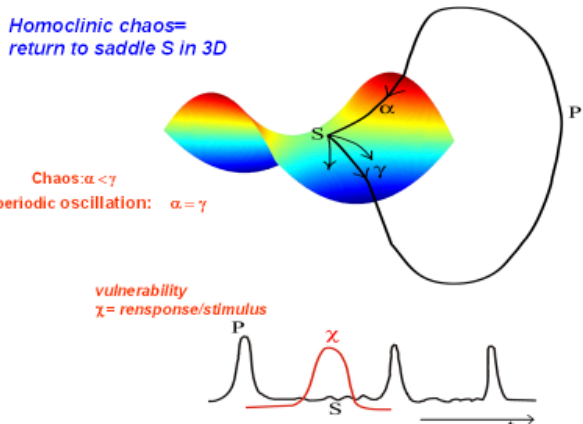
Figure 7. Topology of specialized cortical areas ,each one being active as a large collection of synchronized neurons; mutual com- munication occurs via EEG signals.